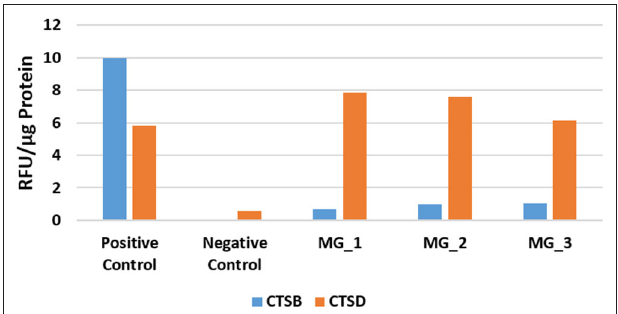
FIGURE 5 | Averaged results of cathepsin B (CTSB) and cathepsin D (CTSD) for three WHO grade I meningioma samples expressed in relative fluorescence units (RFU)/ug of protein, compared to the positive and negative controls.